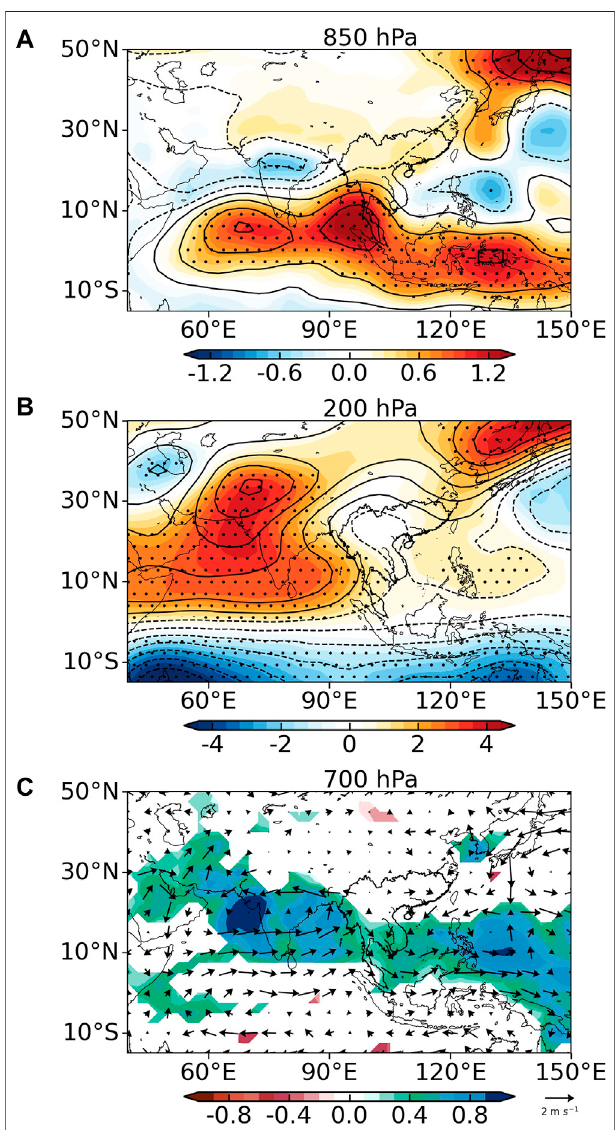
FIGURE 4 | Differences in composite stream functions (contours; units: 10 6 m 2 s − 1 ) associated with extreme precipitation during the subperiods of 1951 – 2002 and 2003 – 2015 at (A) 850 hPa and (B) 200 hPa. Contours are drawn at intervals of 0.5 and 1 in (A , B) , respectively. (C) is the differences of composite 700-hPa speci fi c humidity (shading, units: g kg − 1 ) and horizontal wind (arrows, units: m s − 1 ) during the subperiods. Stippling in (A , B) and shading in (C) indicate composite values that are statistically signi fi cant at the 90% con fi dence level.